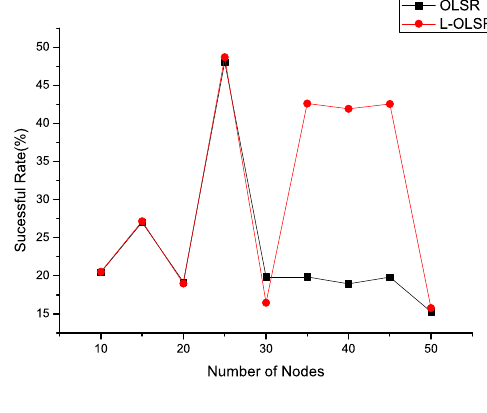
Fig.10. Delivery success rate (DSSS 2M).